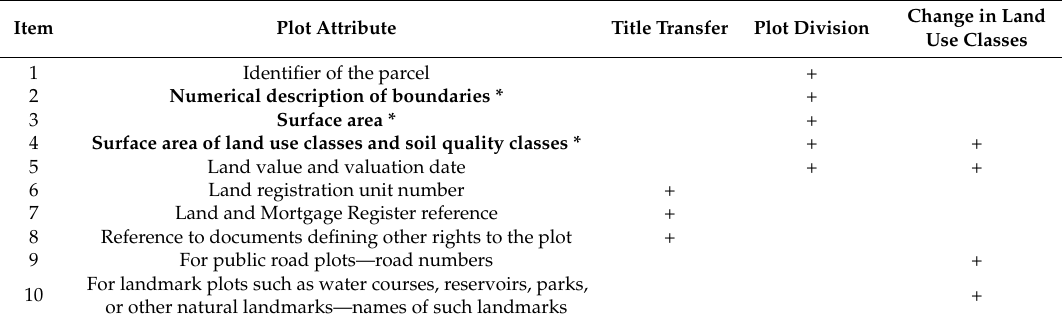
Table 1. Land plot attributes that may change as a result of a